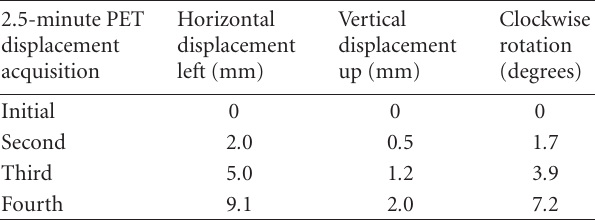
Table 1: Transaxial displacements and rotations from the initial po- sition used in the 3D AC brain-mode acquisition phantom